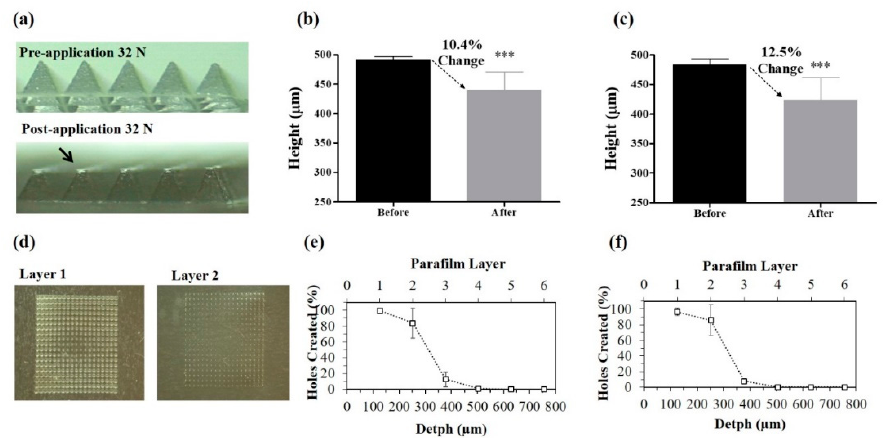
Figure 2. Mechanical characterization of dissolving empty or antigen-loaded Gantrez ® AN119 MN in murine skin. ( a ) Height of MNs pre and post application of MN with a force of 32 N and percentage change of ( b ) empty-MN or ( c ) HT- ∆ tolR -loaded MNs (***, p < 0.001). ( d ) Parafilm layers showing the holes created after the insertion of the MN and the percentage of holes in di ff erent layers correlated with the depth of insertion of ( e ) empty-MN or ( f ) HT- ∆ tolR -loaded MNs.